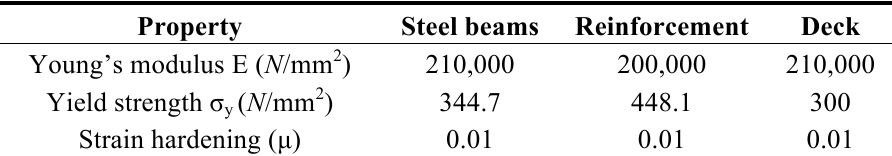
Table 1. Steel material